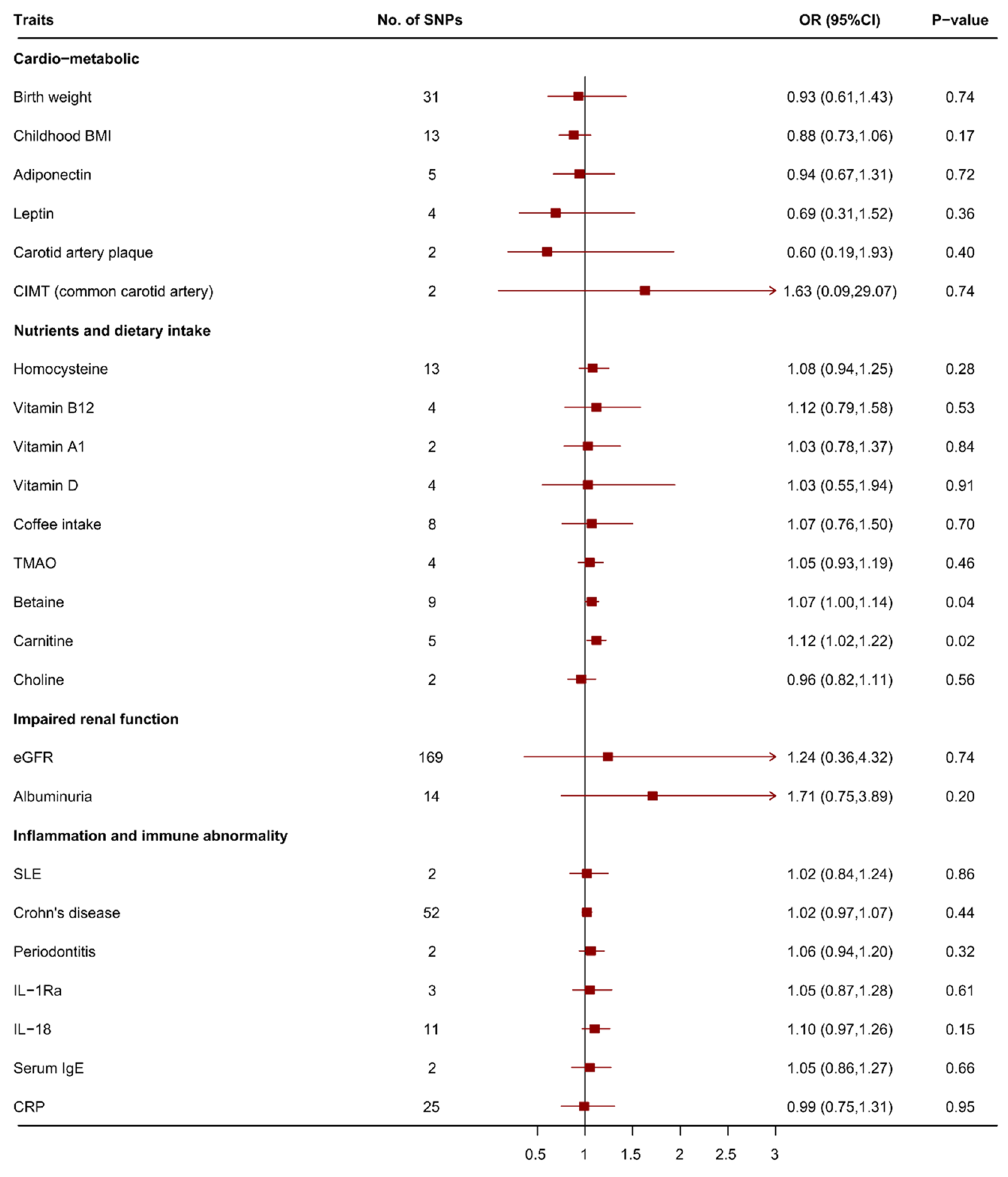
Figure 3. Mendelian randomization for associations between traits of cardio-metabolic, nutrients and dietary intake, impaired renal function and inflammation risk factors and intracranial aneurysm. SNP: single nucleotide polymorphism; OR: odds ratios; CI: confidence interval; BMI: body mass index; CIMT: carotid intima media thickness; CRP: C reactive protein; eGFR: estimated glomerular filtration rate; SLE: systemic lupus erythematosus; TMAO: